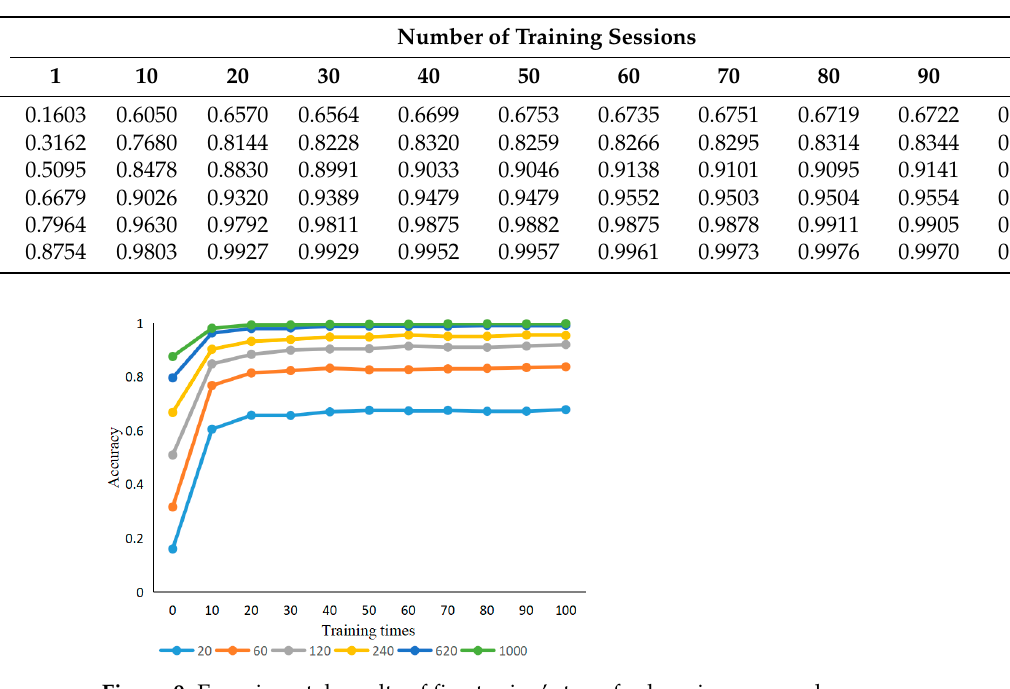
Figure 9. Experimental results of fine tuning’s transfer-learning approach.